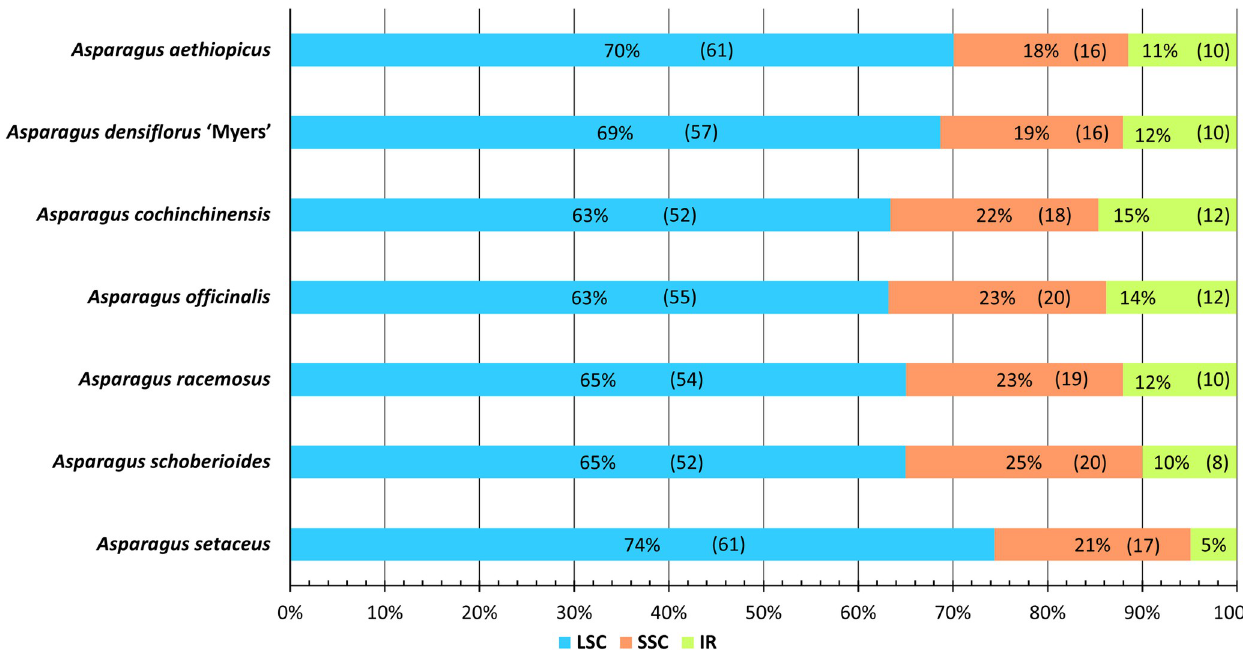
Fig 5. Simple sequence repeat distribution in the quadripartite cpDNA structure. The percentages for each region are shown in the middle of each bar. The numbers in brackets are the actual numbers of SSRs distributed in the indicated cpDNA regions.